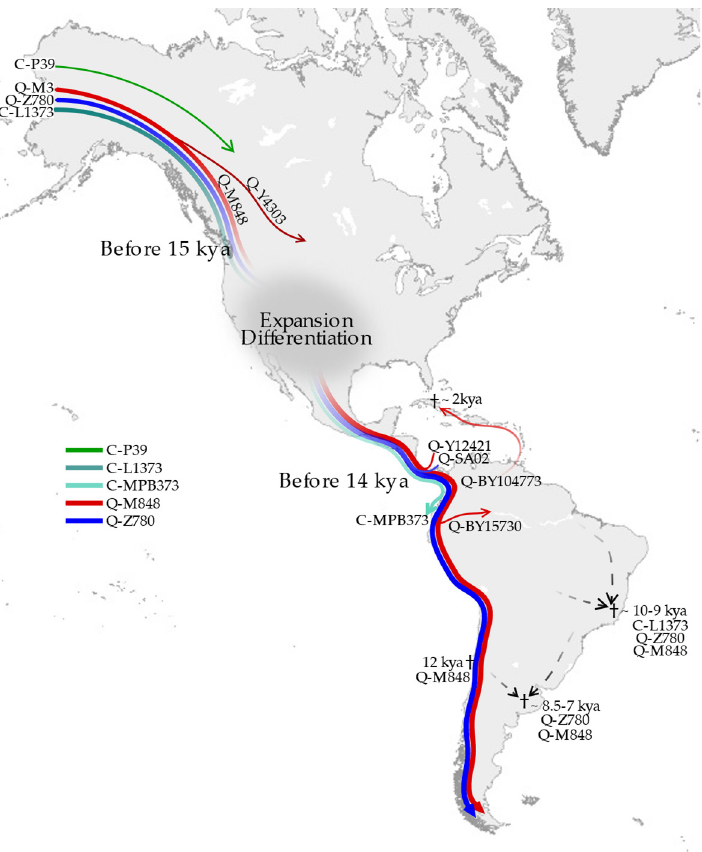
Figure 12. Graphical summary of the main migratory events from North towards South America according to the Y-chromosome variation. Dashed lines represent hypothetical migratory routes; (†) marks archaeological sites.